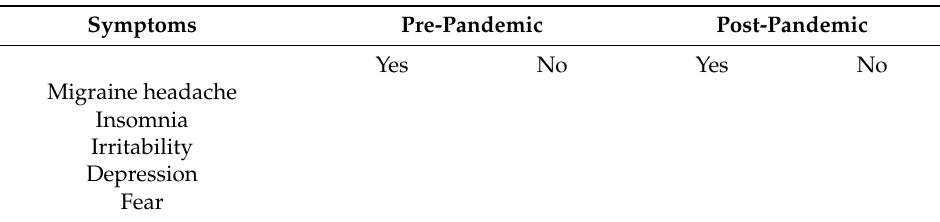
Table 1. Possible Symptoms (migraine headache, insomnia, irritability, depression and fear) suffered pre-pandemic and